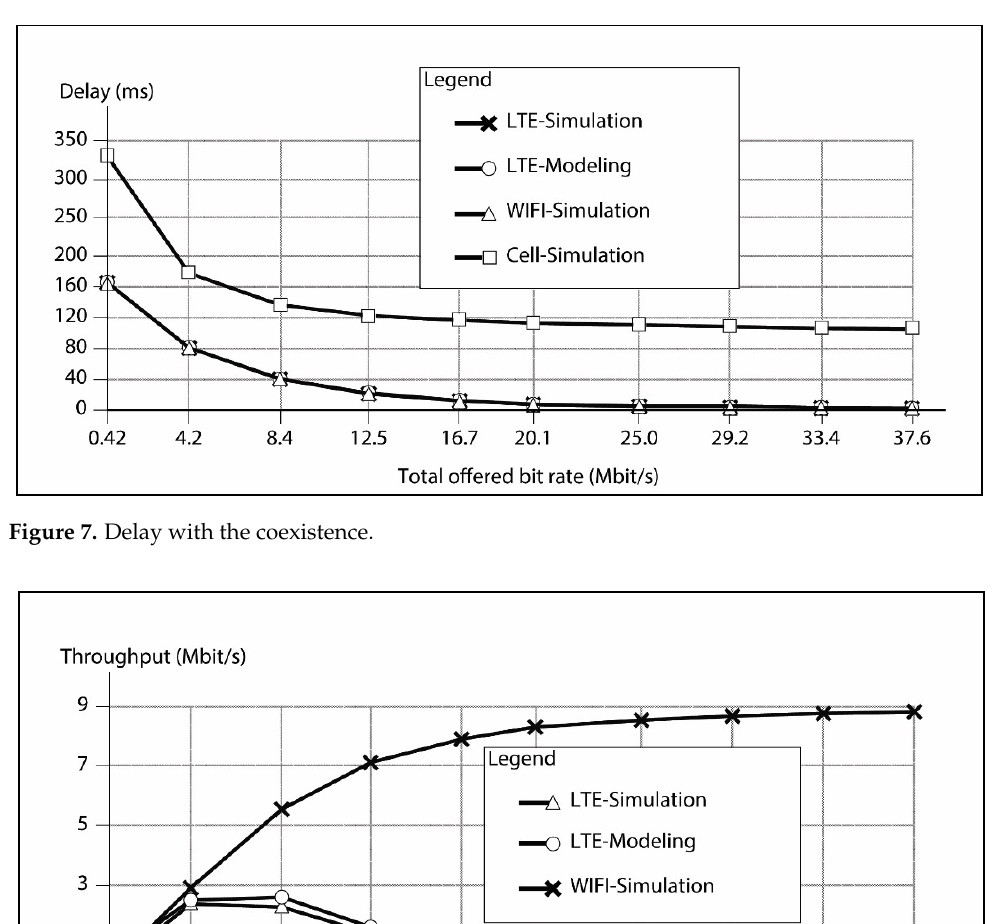
Figure 6. Blocking probability with the coexistence.